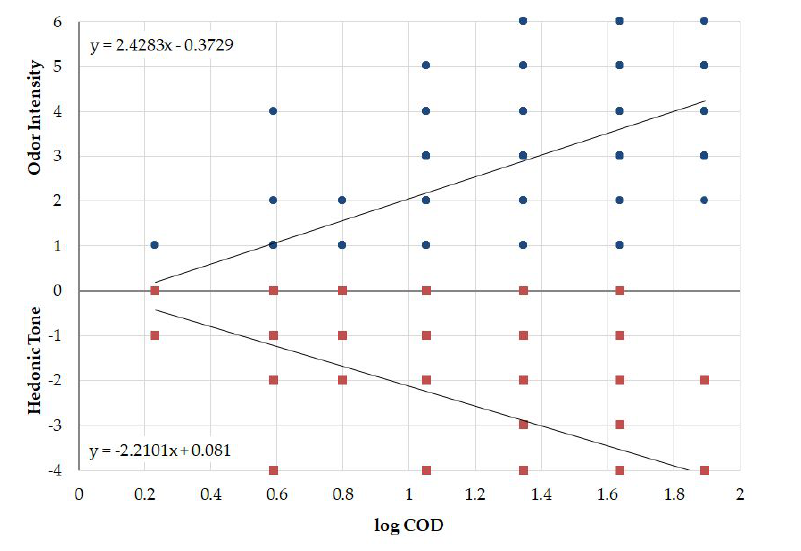
Figure 4. Dependence of odor intensity and hedonic tone on odor concentration carried out at the municipal treatment